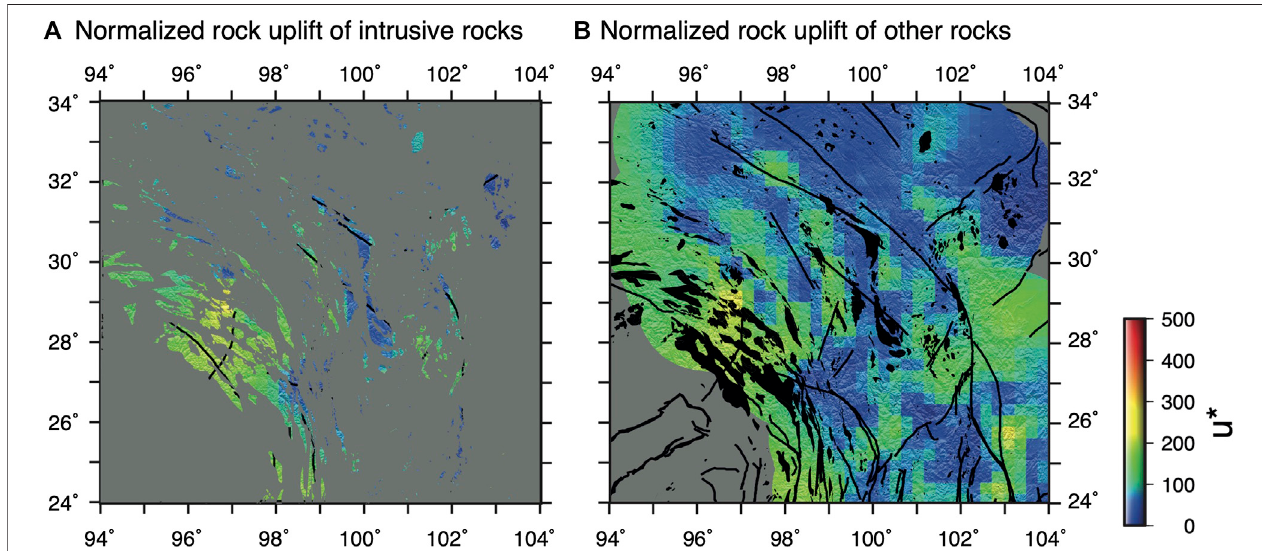
FIGURE 10 | The in fl uence of lithology on predicted normalized rock uplift rate. (A) Intrusive rocks colored by the predicted normalized rock uplift rates with the faultsincludedasin Figure5B .Abandofhigh u* canbeseenatapproximately28 o N97 o Wwhichcorrespondstoadensebandofintrusiveunits.However,highandlow valuesof u* areobservedacrossthearea; (B) Theoppositeof Figure10A showingthepredictednormalizedrockupliftratesfortheotherlithologies,withtheoutcropsof intrusive rocks shown in black. High and low values of u* are observed across both lithological categories and the correlation is not clear. Geological units are simpli fi ed after Pan et al.